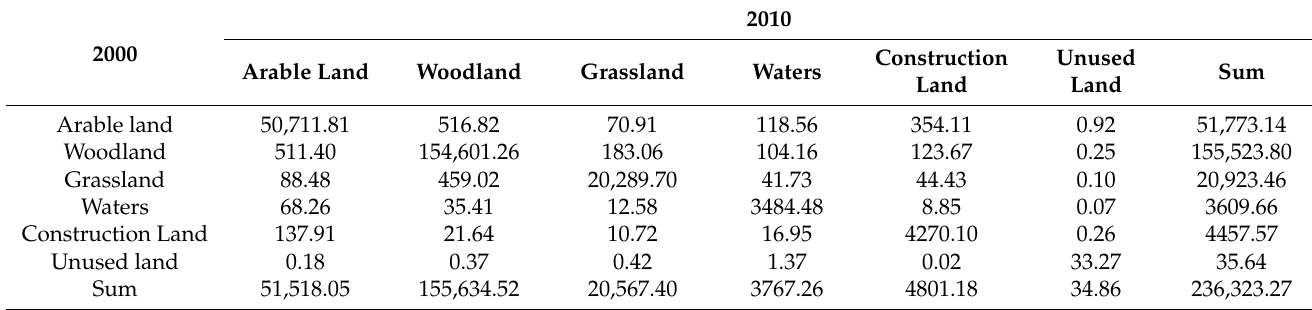
Table 3. Matrix of land-use type transfer in Guangxi from 2000 to 2010 (unit: km 2 ).